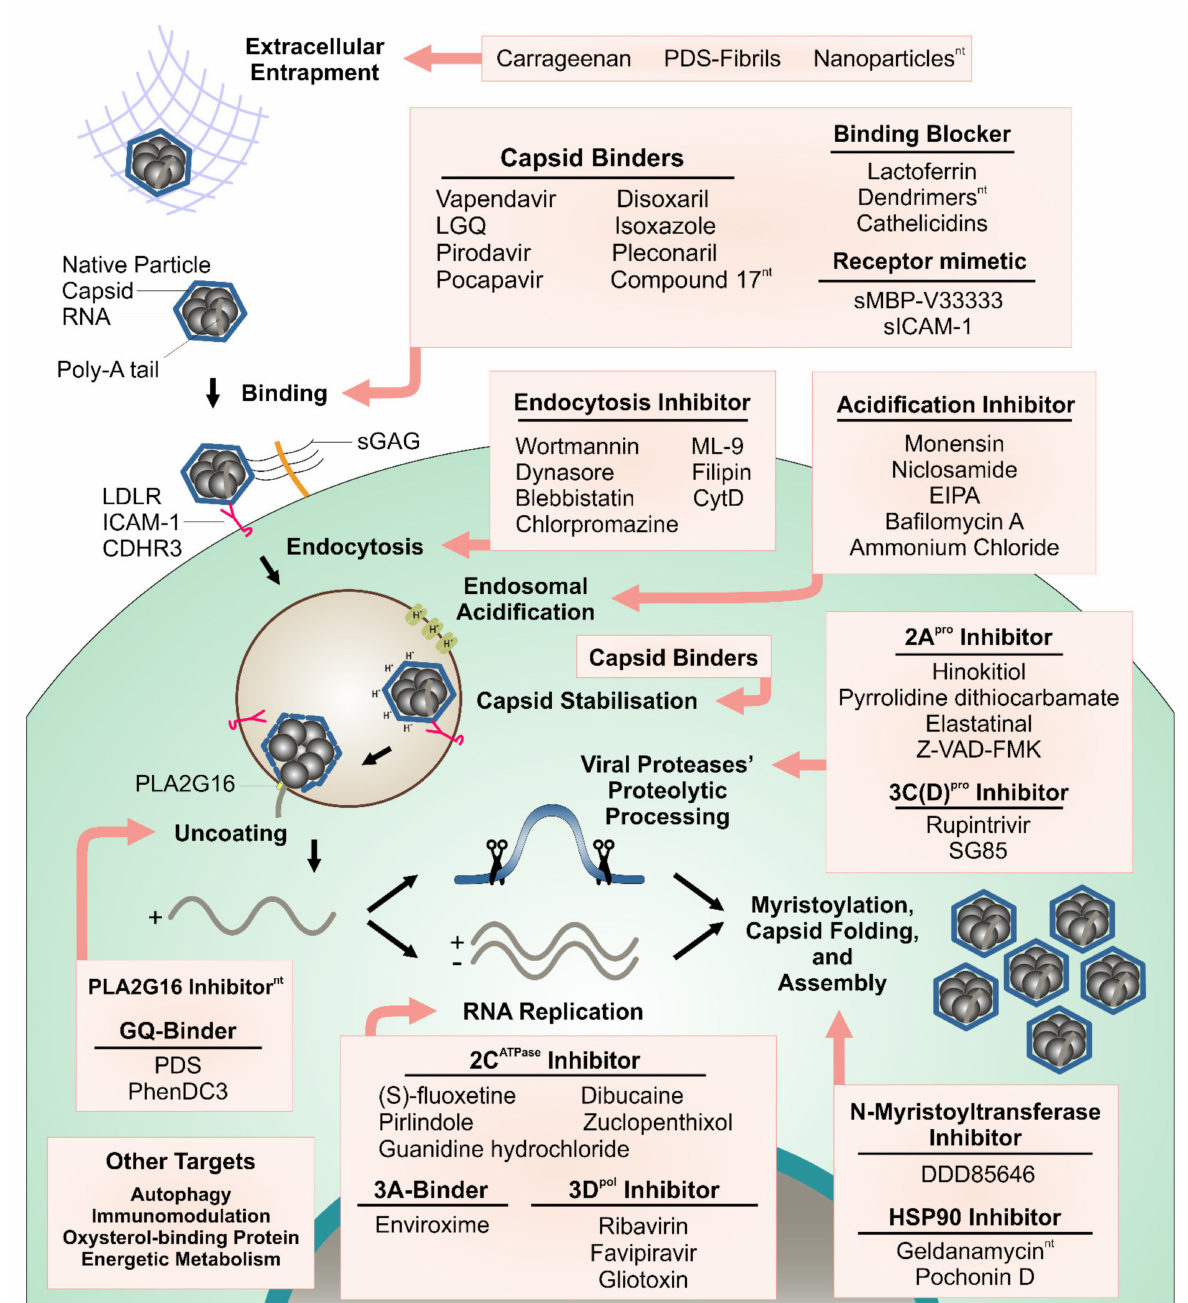
Figure 1. Anti-RV targets and corresponding inhibitors. Steps of the rhinovirus replication cycle targeted with antiviral compounds. Note that the publication on the pla2g16 inhibitor LEI110 does not mention anything related to RV (see text and Table 3). nt , inhibition of RVs not explicitly demonstrated but tentatively inferred from inhibition of other Enteroviruses